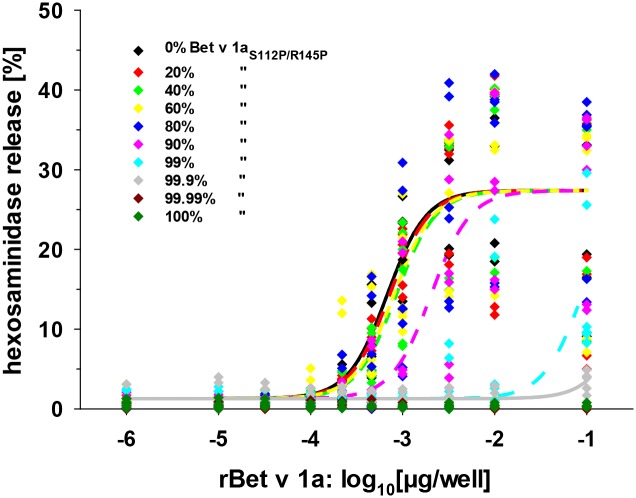
Mediator release of humanized rat basophils.β-hexosaminidase release of humanized rat basophil leukemia cells sensitized with a pool of human sera of donors allergic to birch pollen. Cross-linking of membrane-bound human IgE by IgE-Bet v 1 interaction and subsequent release of β-hexosaminidase was determined in the presence of defined molar ratios of rBet v 1a/rBet v 1aS112P/R145P. The legend shows molar ratios (in %) of rBet v 1aS112P/R145P in the rBet v 1a/rBet v 1aS112P/R145P combinations analyzed.